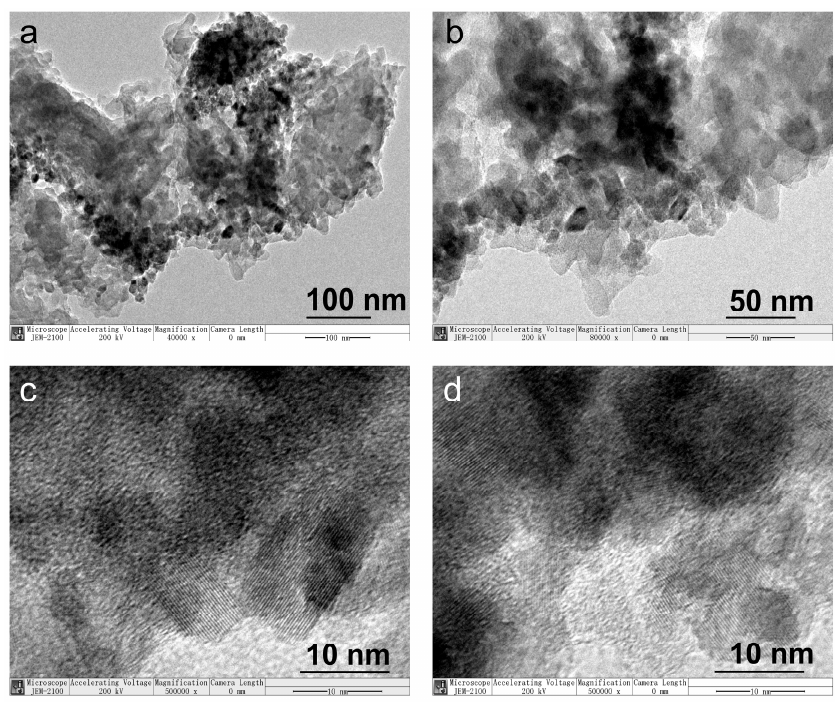
Figure 5. TEM images of 5TC-TBCN at different magnifications: ( a ) 4000 × ; ( b ) 8000 × ; ( c – d ) 500,000 ×